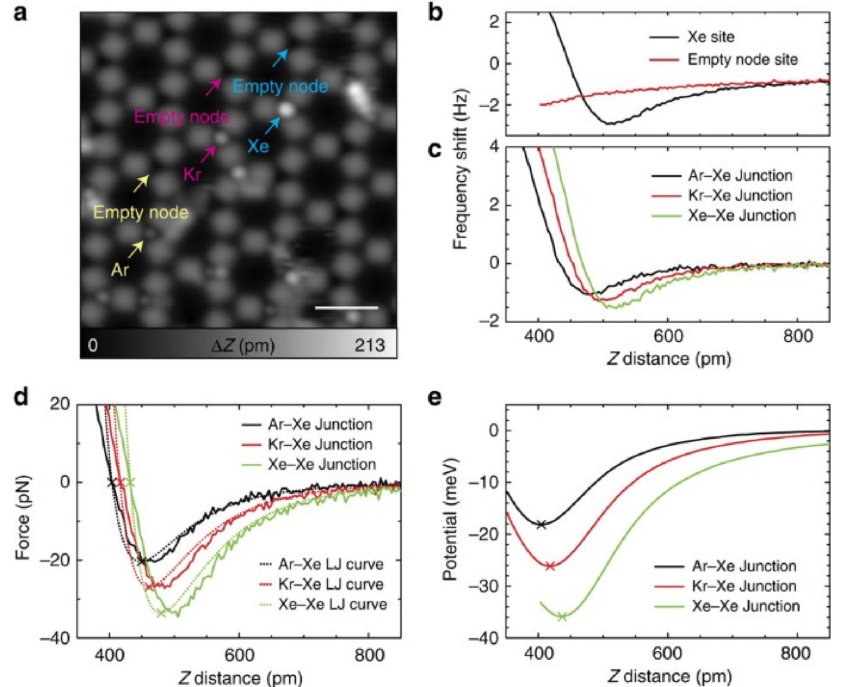
Figure 8. ( a ) STM topography of the Cu-coordinated 3deh-DPDI network after measuring interaction curves above Ar, Kr and Xe atoms. ( b ) Frequency shift curves taken at the equivalent node sites with and without a Xe atom, measured with a Xe-functionalized tip. ( c ) Subtracted distance-dependence curves of the frequency shift for Ar–Xe, Kr–Xe and Xe–Xe junctions. ( d ) Extracted atomic Ar-Xe, Kr- Xe and Xe-Xe interaction forces and Lennard-Jones fits for each system, derived from the frequency shift signal and ( e ) the equivalent potential energy curves. Measurement parameters: V tip = 500mV and I = 4pA in a, and A = 38pm, f = 23063Hz and Q = 52044, and V = 1mV in b,c. Scale bar, 2nm. Adapted with permission from Springer Nature from Figure 3 in